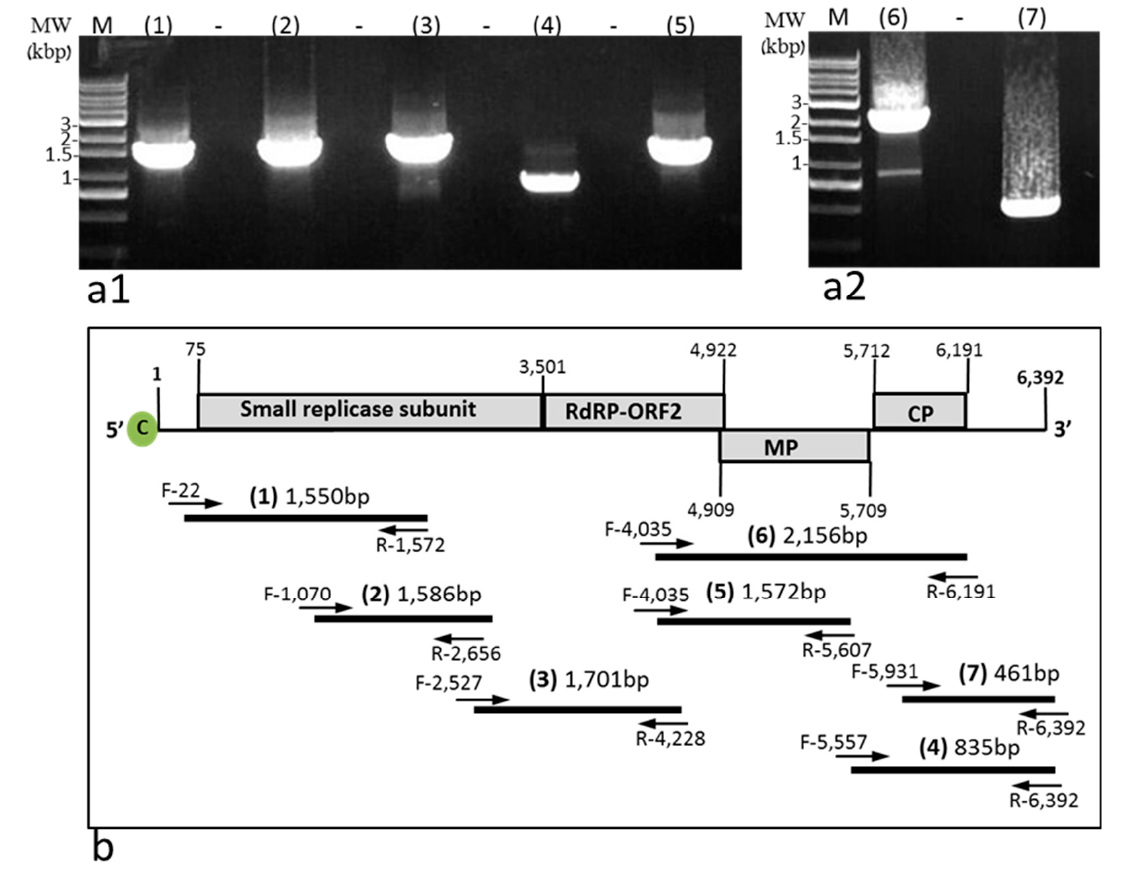
Figure 6. Infectious ToBRFV in systemically infected L 0 cv. 6210 plants: ( a1 , a2 ) RT-PCR of ToBRFV in leaves of systemically infected L 0 cv. 6210 plants using the primer sets 1–7 illustrated in ( b ); ( b ) a scheme of ToBRFV genome showing total genome coverage by the amplicons amplified in ( a1 , a2 ). In order to confirm the establishment of ToBRFV in the infected L 0 cv. 6210 plant tissues, we have examined the plant seeds for virus distribution using in situ immunofluorescence (Figure 7). ToBRFV localization in the infected seeds, studied by in situ immunofluores- cence, revealed that ToBRFV infected the inner maternal-derived tissues (Figure 7(c1–c3)). Apparently, ToBRFV in seeds of foliar-inoculated L 0 cv. 6210 plants were not restricted to the epidermis of the seed coat but were localized in the inner parenchyma and in the endothelial cells bordering the endosperm as well (Figure 7a,b,(c1–c3)). Seeds of L 1 Lapid that were ToBRFV-negative, shown by a Western blot and double RT-PCR (see Materials and Methods) (Figure 3(b2,4e)), served as a negative control (Figure 7(d1–d3)). ToBRFV- infected seeds of L 0 plants cv. 6210 showed a ToBRFV PCR product of 1122 bp (Figure 7e). These data further indicated that foliar-inoculated L 0 cv. 6210 plants had a stable systemic infection of ToBRFV, which allowed the virus to penetrate the parenchyma and the en- dothelium through the maternal precursor tissues [23]. However, ToBRFV seed infection was not associated with disease symptom manifestations on fruits of L 0 cv. 6210 plants (Figures 3d and